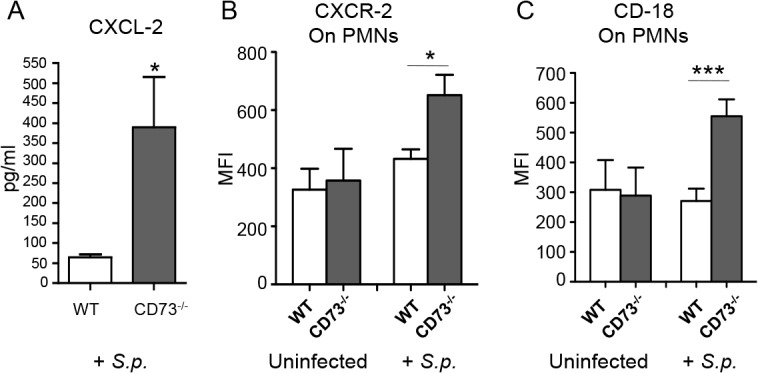
CD73 modulates the induction of leukocyte recruitment signals upon I.T. challenge by S. pneumoniae.Wild-type C57BL/6 or CD73
-/- mice were mock-infected or I.T. challenged with 5 x 103 CFU of S. pneumoniae TIGR4 (+S.p). Three days after challenge, levels of CXCL-2 in the lung homogenates were determined by ELISA (A) and the mean florescent intensities (MFI) of CXCR2 (B) or CD18 (C) on PMNs (Ly6G+) recruited into the lungs were determined by flow cytometry (see Materials and Methods). Pooled data from two separate experiments (n = 6 infected and n = 4 uninfected mice per group) are shown. Data represent means +/- SEM, and significant differences determined by Student’s t-test are indicated by asterisks (*** = p< 0.0001 and * = p<0.05).